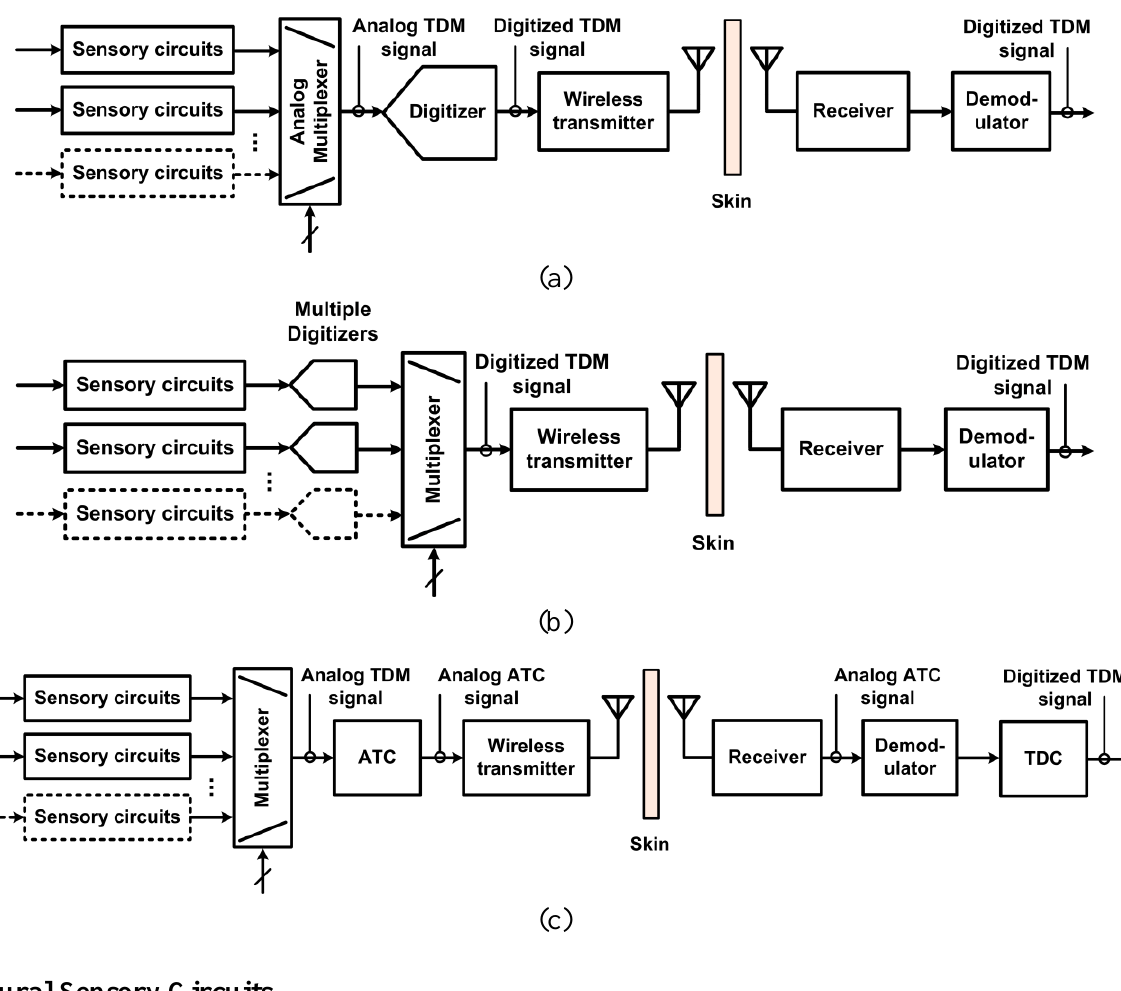
Figure 1. Block diagrams showing different neural recording microsystem